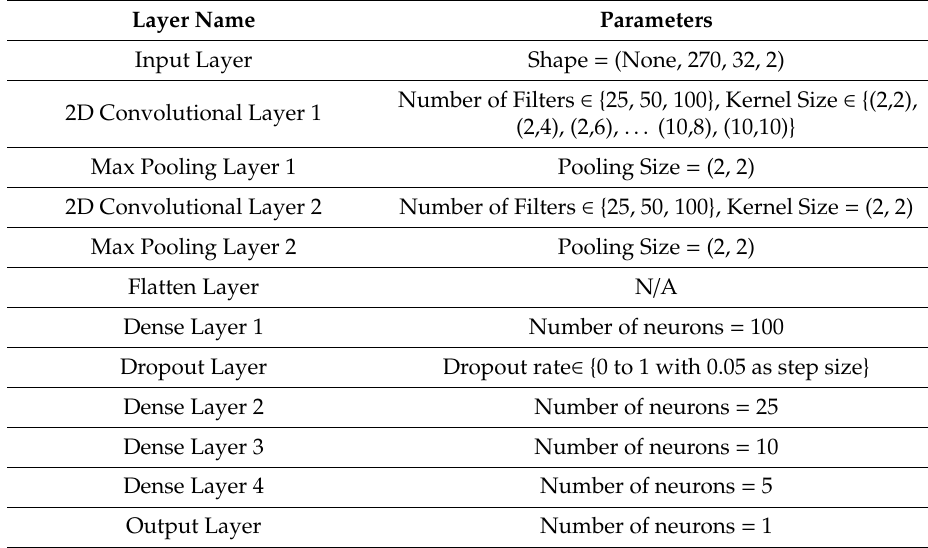
Table 1. Convolutional neural network (CNN) structural configuration. All the convolution layers and fully connected layers (dense layers) used exponential linear unit (ELU) as activation function. Batch size ∈ {64, 128}andtrainingiterations ∈ {100, 150,